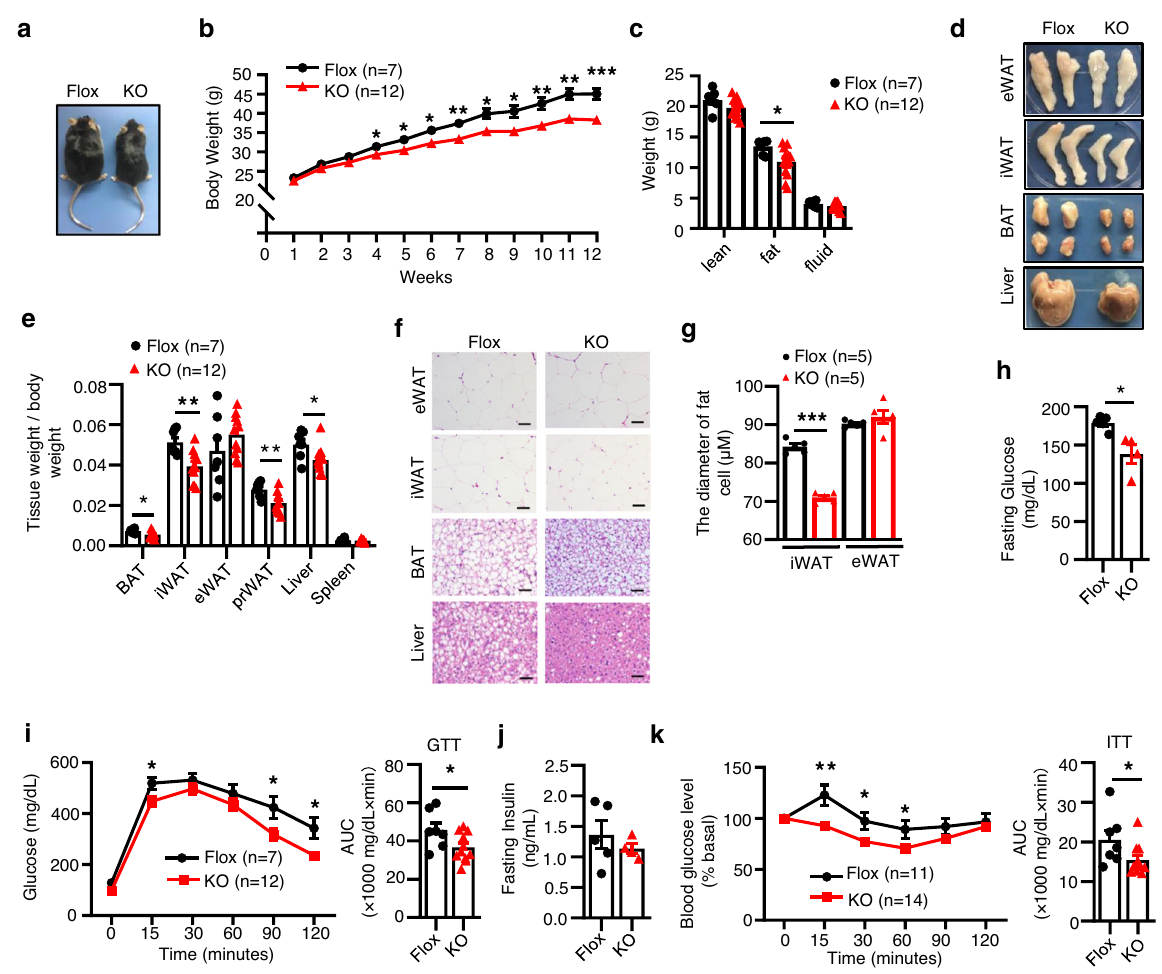
Fig. 3 T cell-speci fi c knockout of DsbA-L alleviates diet-induced obesity and insulin resistance. a Representative images of mice after a 12-week HFD feeding regimen starting at 8 weeks of age. b Body weight gain of DsbA-L CD4-KO mice ( n = 12) and control littermates ( n = 7) during HFD feeding. c Body composition of DsbA-L CD4-KO mice ( n = 12) and control littermates ( n = 7) fed an HFD for 12 weeks. d Representative images of fat pads and liver collected from DsbA-L CD4-KO mice and control littermates fed an HFD for 12 weeks. e Relative tissue weights of HFD-fed DsbA-L CD4-KO mice ( n = 12) and control littermates ( n = 7) fed an HFD for 12 weeks. f Representative H&E staining of eWAT, iWAT, BAT, and liver of DsbA-L CD4-KO mice and control littermates fed an HFD for 12 weeks. Scale bars: 50 μ m. g The average diameters of fat cells in DsbA-L CD4-KO mice and control littermates were analyzed and quanti fi ed by the Image J software. h Fasting glucose levels in DsbA-L CD4-KO mice ( n = 4) and control littermates ( n = 5) fed an HFD for 12 weeks. i Glucose tolerance test was performed in DsbA-L CD4-KO mice ( n = 12) and control littermates ( n = 7) fed an HFD for 12 weeks. j Fasting insulin levels in DsbA-L CD4-KO mice ( n = 4) and control littermates ( n = 5) fed an HFD for 12 weeks. k Insulin tolerance test was performed in DsbA-L CD4-KO mice ( n = 14) and control littermates ( n = 11) fed an HFD for 12 weeks. Data shown are representative of three independent experiments. All data are presented as mean ± SEM. Statistical values p < 0.05 (*), p < 0.01 (**), p < 0.001 (***) are determined by two-tailed unpaired Student ’ s t -test. Source data are provided as a Source Data File.